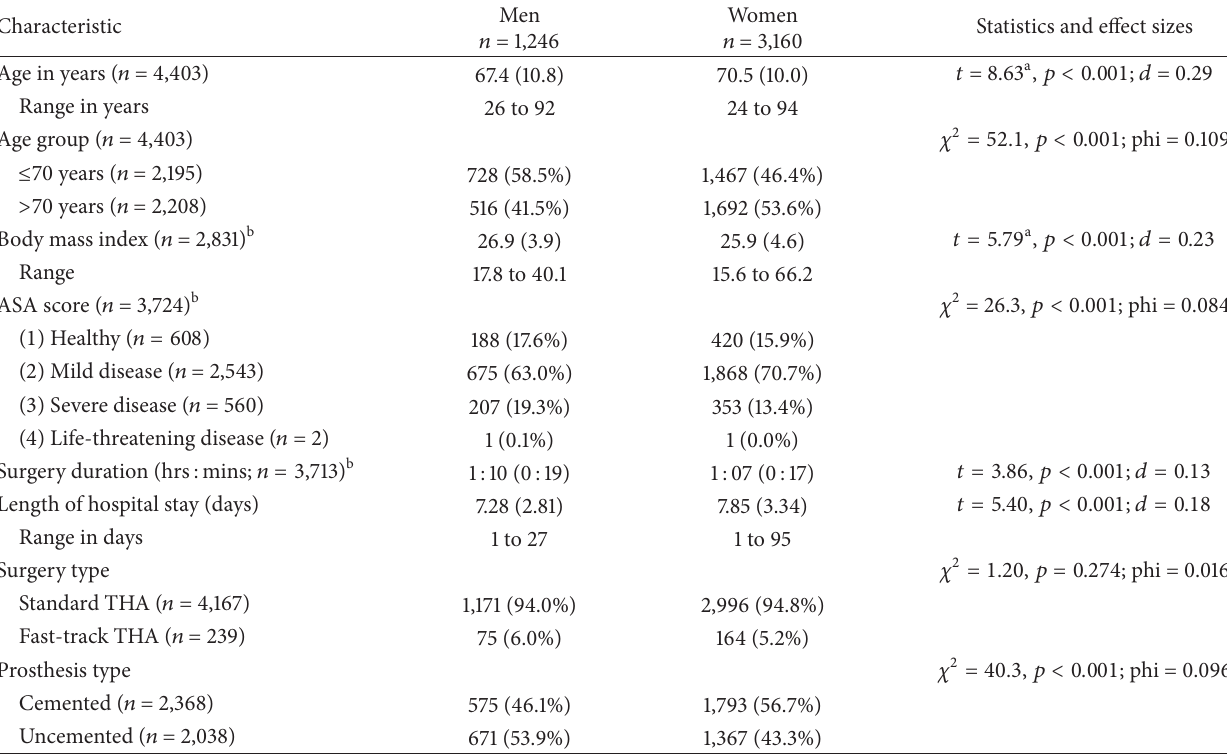
Table 1: Patient demographic and clinical characteristics ( 𝑛 =